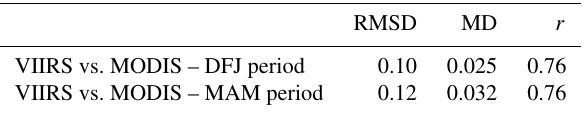
Table 4. Quantification of global AOD differences between VIIRS vs. MODIS over land for the DJF and MAM